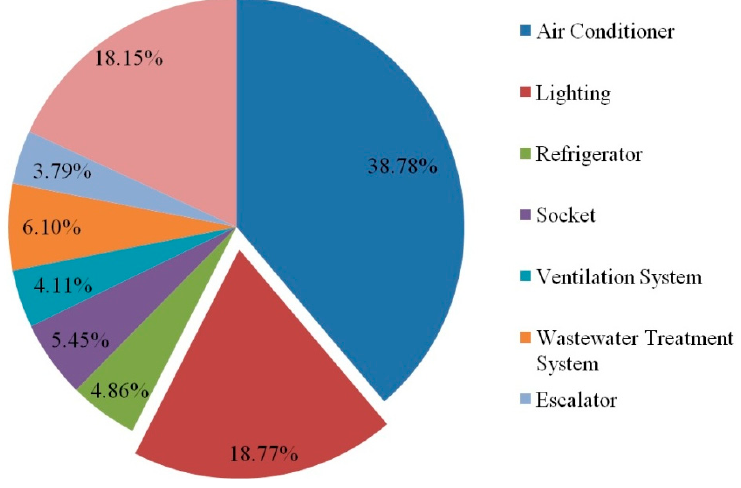
Figure 2. Statistical results of the energy consumption by various electrical devices in buildings.